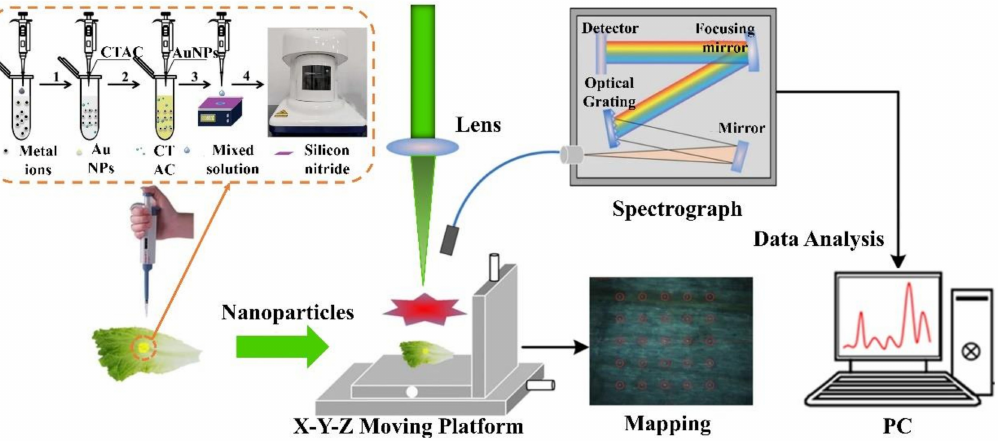
Figure 2. Enhancement of LIBS signal by nanoparticles. The process of sample making and experi- mental equipment for nano-particle